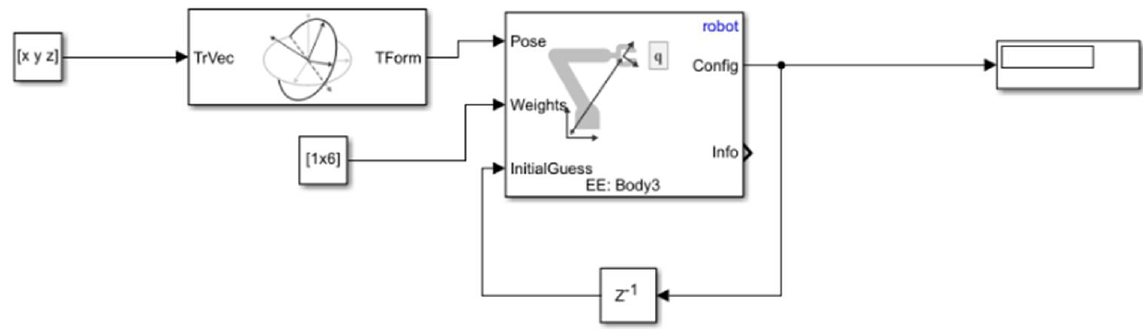
Figure 8. SAMA inverse kinematics model.